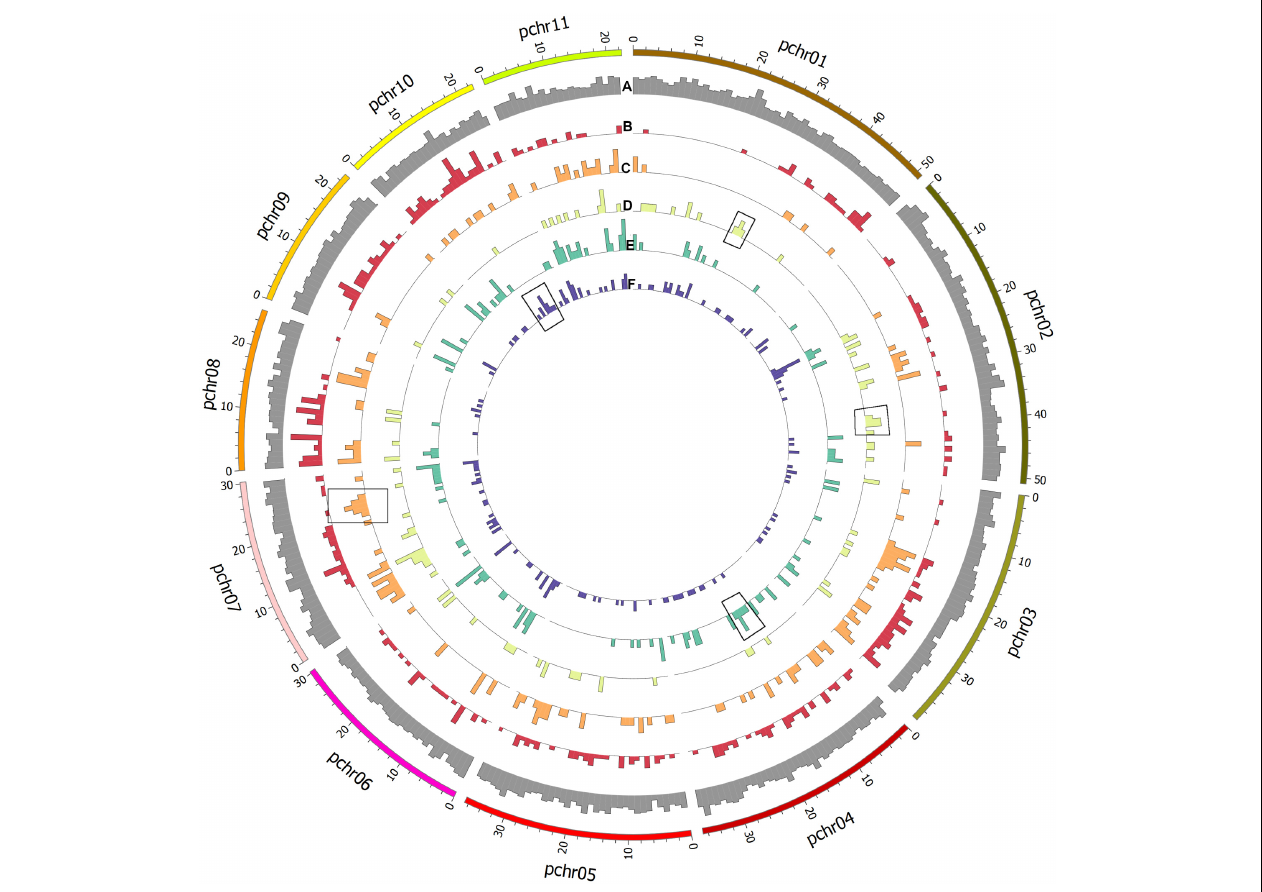
FIGURE 5 | Circular plot showing histograms of the number of assembled Stacks loci mapped to the genome assembly of C. avellana var. ‘Tombul’. Outermost ring shows the relative density of all loci (A) by genome position. Polymorphic loci were selected, and alleles that differed from the reference genome and were present in specific populations were mapped for each variety. Working from outside to the center of the figure, alternative alleles for the (B) ‘Tombul’, (C) ‘Sivri’, (D) ‘Sarıfındık’, (E) ‘Palaz’, and (F) ‘Çakıldak’ varieties are shown. These include both alleles that are unique to a certain variety (private alleles), and those which are shared between some varieties but absent in